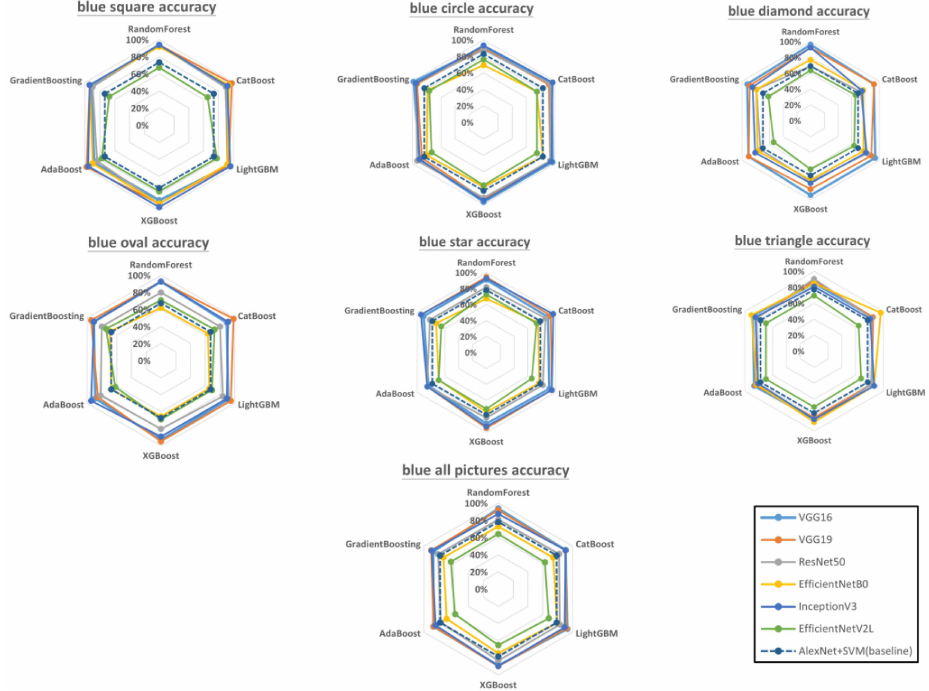
Figure 12. Accuracy of each model combination for blue-colored geometries (raw data are presented in Appendix C). The dotted regular hexagon is the baseline using AlexNet with